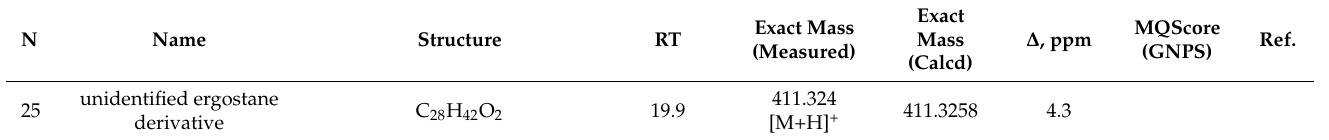
* Compounds were identified through comparison of MS/MS data and retention time with those obtained for authentic standards previously isolated from this fungal strain [8]. ** Compound was identified based on an exact mass